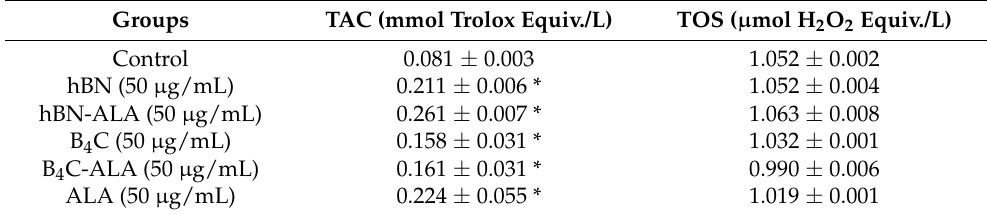
Table 1. Effects of hBN, hBN ‐ ALA, B 4 C, B 4 C ‐ ALA, and ALA on TAC and TOS levels in HDFa cell culture at 24 h. Symbol (*) represents statistically significant difference ( p ≤ 0.05) compared to the negative control.